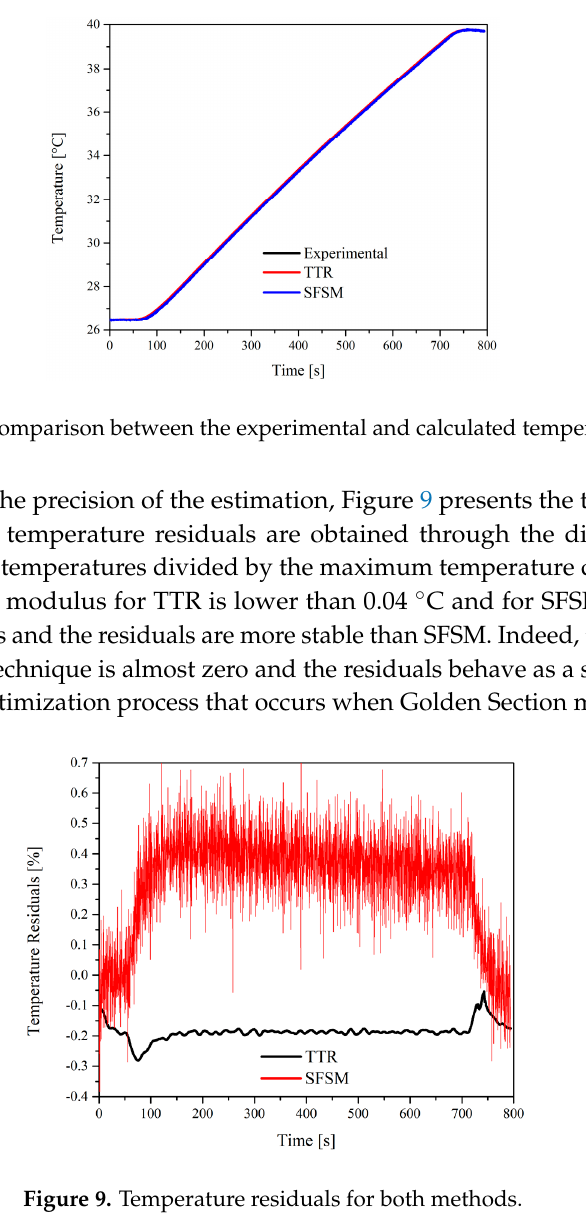
Figure 7. ( a ) TTR, SFSM and experimental heat flux, ( b) Difference of heat flux estimated using SFSM and TTR.